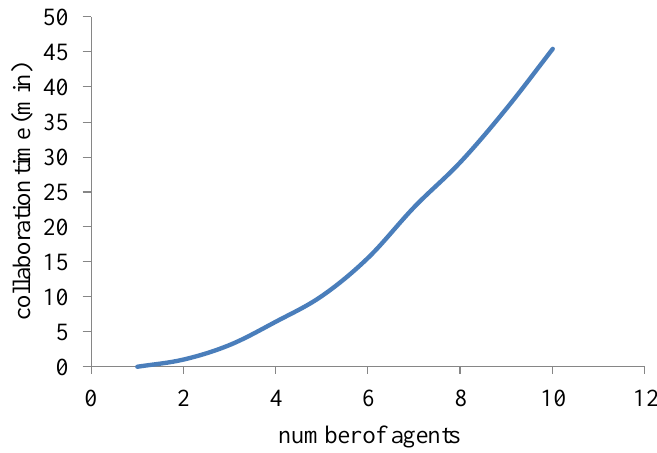
Figure 2. The required collaboration time.